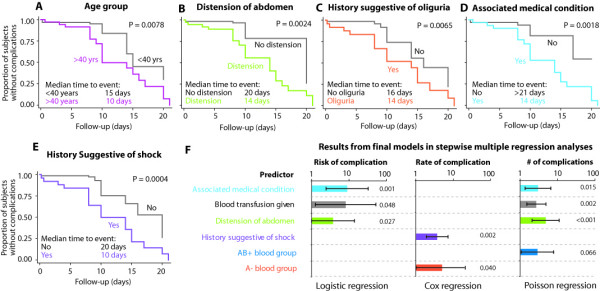
Association of the study factors with postoperative complications. (A to E) Kaplan-Meier (K-M) plots showing the time to development of postoperative complication based on five significant study factors. The significance values (P) was estimated using logrank test. The median time to a postoperative complication across the two categories of each predictor is shown inside each K-M plot. The colors used in the plots correspond to the colors used figure 1A and 1C. The remaining K-M plots are shown in part A of the Additional file. (F) Multiple regression analyses assessing the association of the study factors with three outcomes related to postoperative complications – risk of developing complication (left), rate of developing complication (center) and number of complications (right). For each of these outcomes, we used appropriate stepwise multiple regression models (indicated at the bottom and described in Methods section). The bars represent the risk estimate and the error bars represent the 95% confidence interval. The numbers opposite the bars are significance values obtained from the respective regression analyses. The full results of these models are given in part B of the Additional File 1